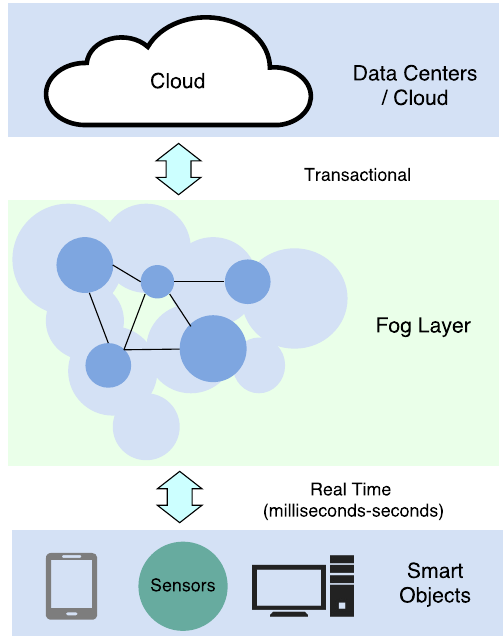
Figure 14. Fog computing